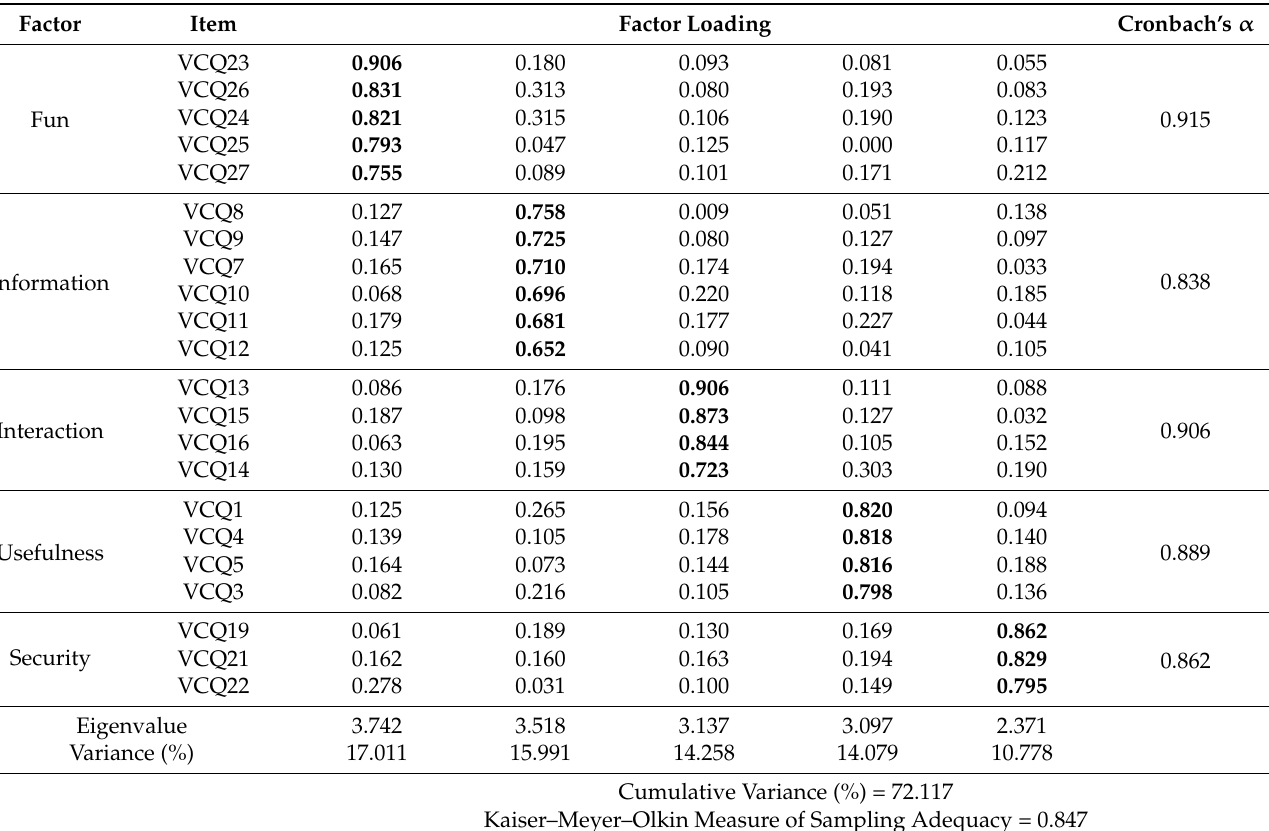
Table 5. Exploratory factor analysis and reliability for video conference quality.